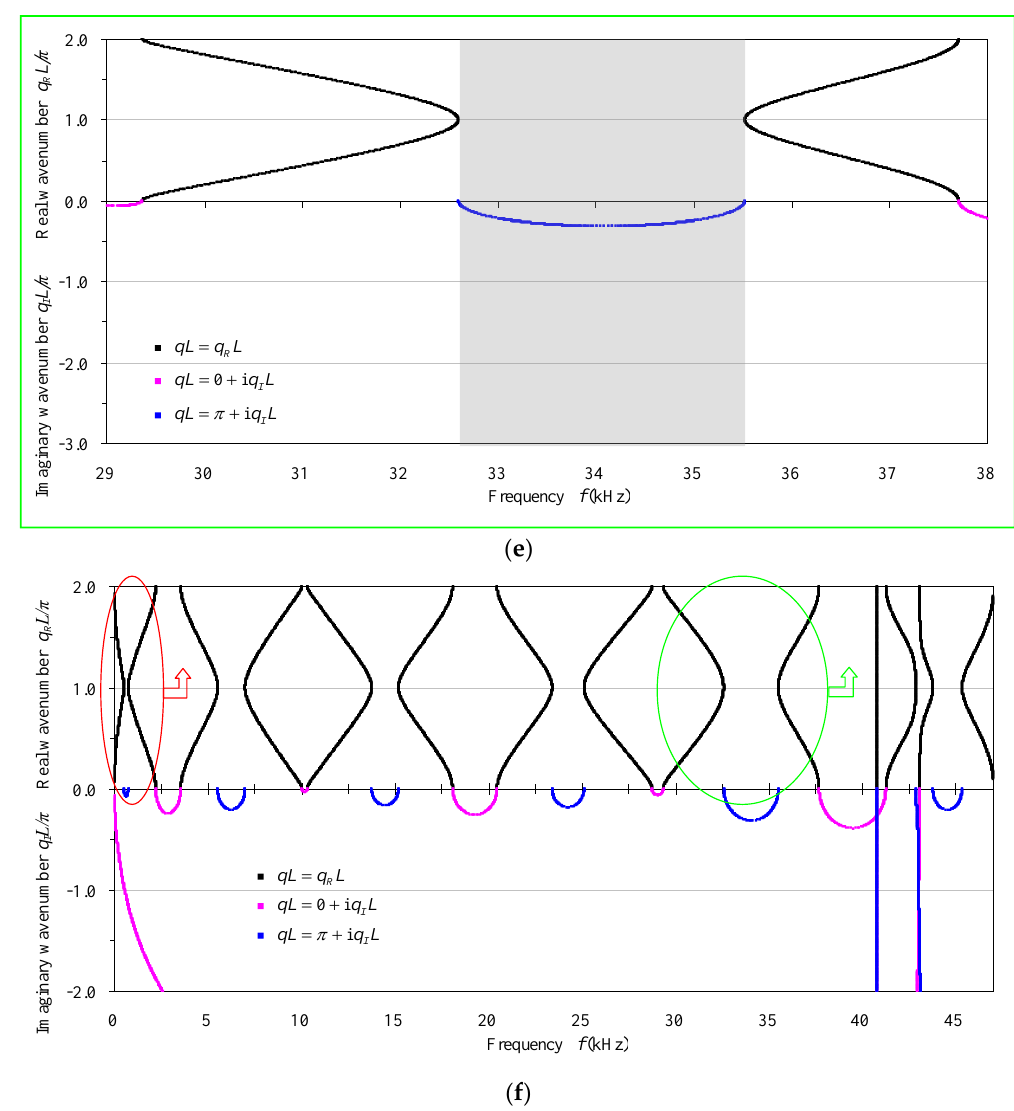
Figure 8. The computational transmission spectra and band structures at a typical high frequency range 29 kHz ≤ f ≤ 38 kHz: ( a ) Transmissions of the defected and perfect phononic crystal beams by the MRRM; ( b ) Band structures of the defected phononic crystal beam as a supercell by the TMM; ( c ) Band structures of the defected phononic crystal beam as a supercell by the MRRM; ( d ) Band structures of the perfect phononic crystal beam based on supercell of eight unit cells by the MRRM; ( e ) Band structures of the perfect phononic crystal beam based on one unit cell by the MRRM; ( f ) Band structures of the perfect phononic crystal beam based on one unit cell by the MRRM within f ≤ 47 kHz.